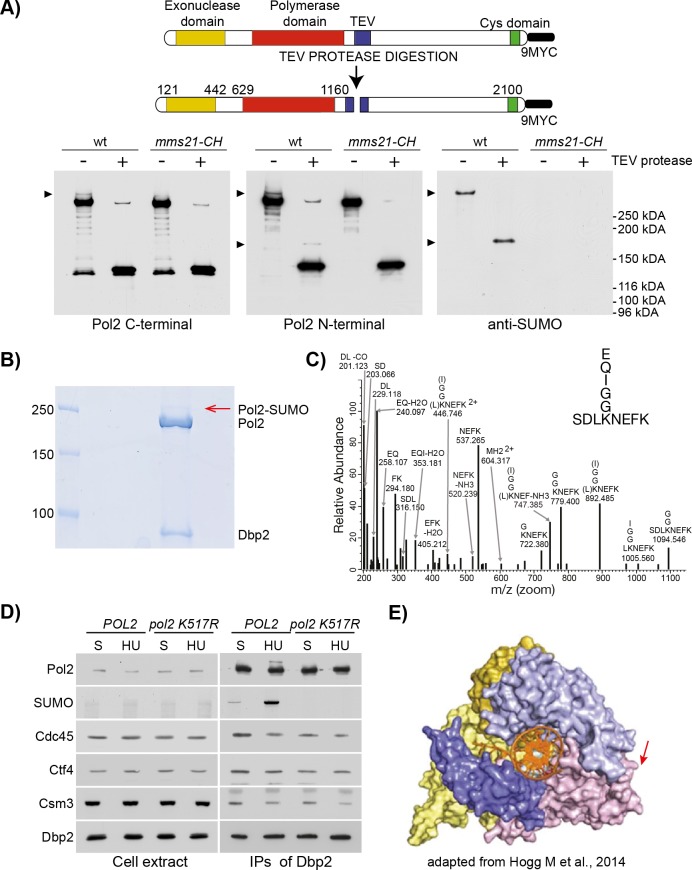
Pol2 is SUMOylated at K571.A) Mms21 SUMOylates Pol2 N-terminal half. (Top). A graphic representation of the Pol2 allele used in the experiment is shown. POL2 was tagged at the C-terminal with a 9MYC tag. In addition, a 3xTEV sequence was inserted at the position S1227. (Bottom). Wild type and mms21-CH mutant cells, carrying the POL2-(3TEV)-9MYC allele, were grown to exponential phase, arrested in G1 and synchronously released in YPD 0.2 M HU for 90 min. Pol2 was then immunoprecipitated, incubated in the presence or absence of the 20 units of TEV protease, eluted by boiling and analysed by immunoblotting. The N-terminal part of Pol2 was detected with a polyclonal antibody raised against the N-terminal half of Pol2, while the C-terminal half was examined with an anti-MYC antibody. B) Mass spectrometry analysis reveals a single putative site of SUMOylation at Lysine 571. (Left) Cells carrying a Dpb2 TAP-tagged allele were synchronously released in medium containing 0.2 M HU for 90 min. Pol ε was immunoprecipitated at 700 mM potassium acetate and eluted by TEV cleavage. Samples were analysed by electrophoresis and stained in Coomassie blue. The Pol2-SUMO band was cut and digested with trypsin for mass spectrometry analysis. C) MS/MS spectrum showing Pol2 modification at K571 by SUMO. D) Pol2 SUMOylation is abolished in a K571R mutant. Cells carrying a DPB2 TAP-tagged allele and a wild type or a pol2 K571R (pol2KR) allele were grown to exponential phase, arrested in G1 and synchronously released either in fresh medium for 30 min (S) or in YPD 0.2 M HU for 90 min (HU). Dpb2-TAP was immunoprecipitated and analysed by immunoblotting. E) K571 is in the palm domain of Pol2. Illustration of the position of K571 within Pol2 N-terminal crystal structure (81). K571 is in a Pol2-specific large insertion within the palm domain.